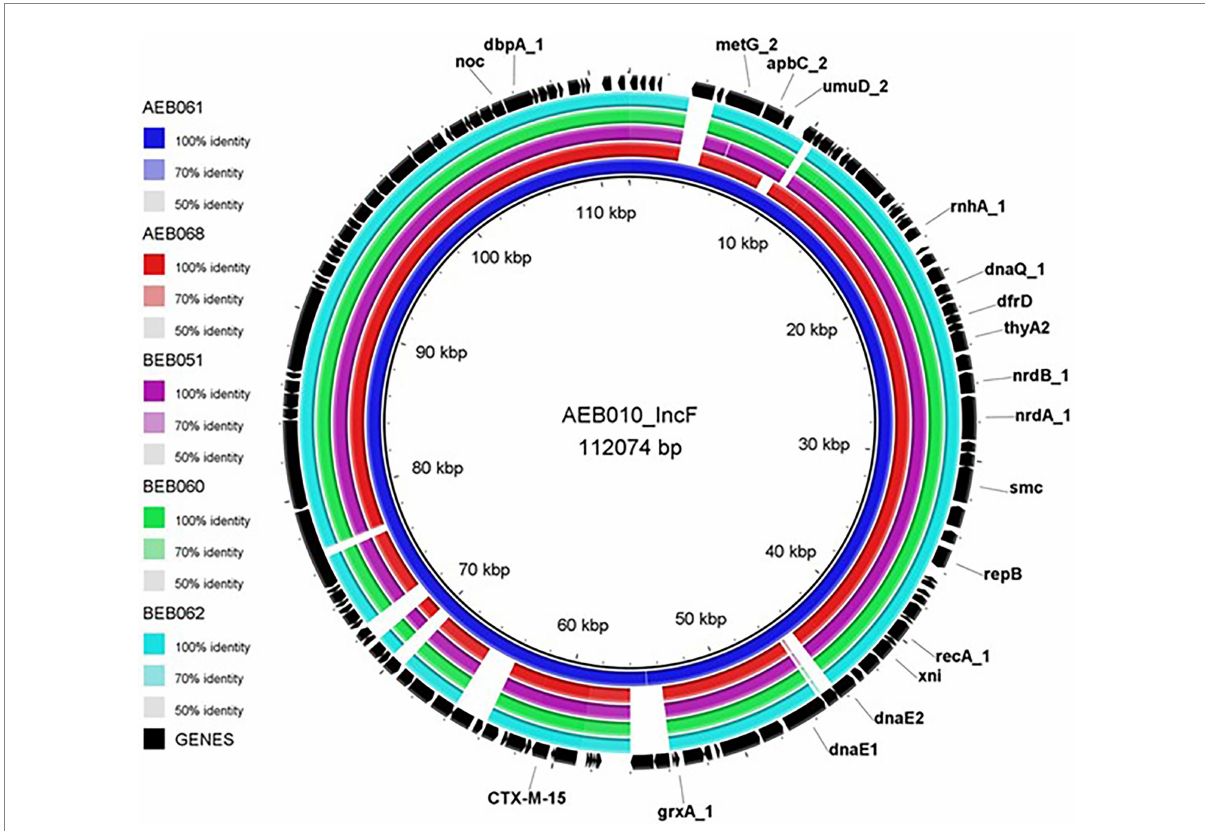
FIGURE 3 BRIG image comparing the IncFIB plasmid in AEB010 isolate with other E. coli isolates carrying the bla CTX-M-15